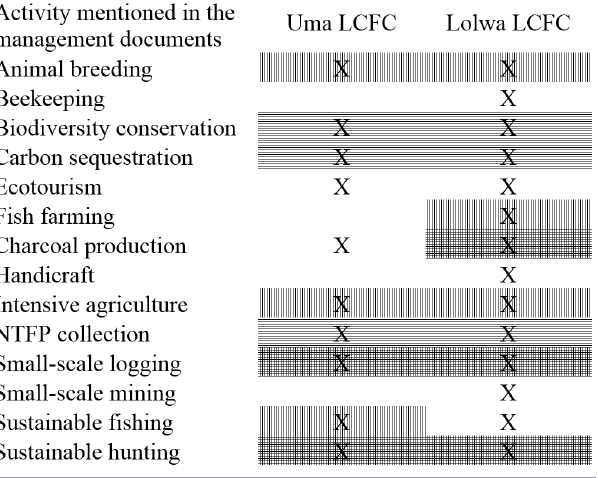
Fig. 3 . Activities planned in the community forests. Those that were associated with forest space are marked out with horizontal lines, those for which at least some benefits and/or costs were quantified in the management documents are marked out with vertical lines, and those that combined these two characteristics are marked out in